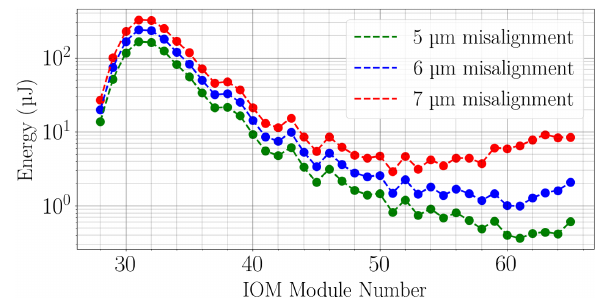
FIG. 19. IOM output energies for one quadrupole misalignment of 5, 6, and 7 μ m, showing instability developing for the 7 - μ m misalignment case.